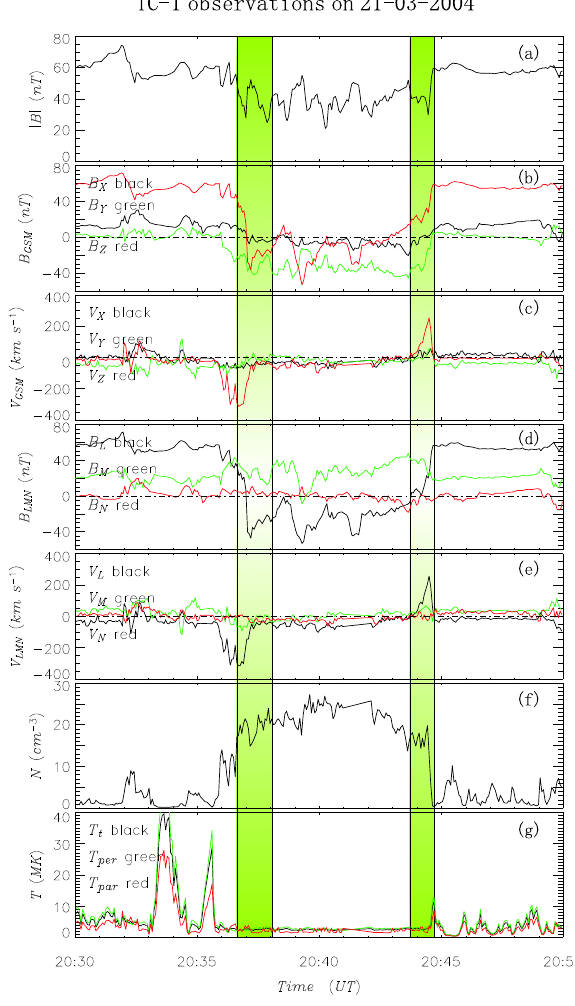
Fig. 1. TC-1 measurements for the two magnetopause crossings on 21 March 2004. 21 March 2004 (details are shown in the